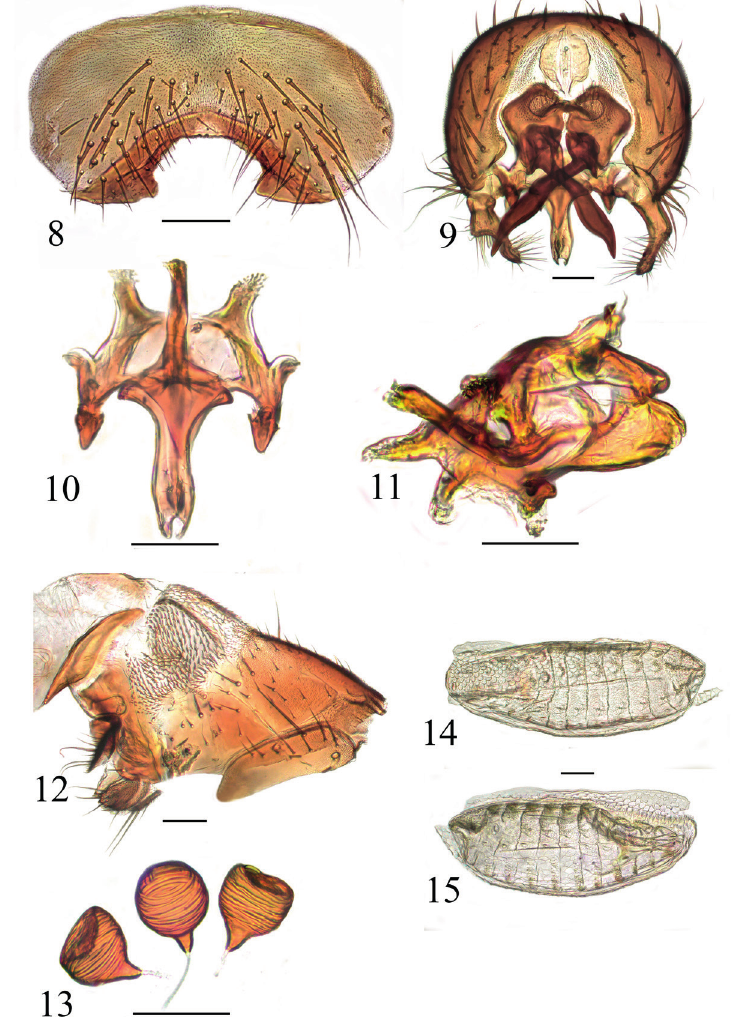
Figures 8-15 - Fannia capitalis Pont 1977: 8 . Sternite 5, male, frontal view; 9 . Male terminalia, frontal view; 10 . Phalic complex, dorsal view; 11 . Phalic complex, lateral view; 12 . Ovipositor, lateral view, 13 . Spermathecae; 14 . egg, dorsal view; 15 . egg, lateral view. Scale bars = 0.1